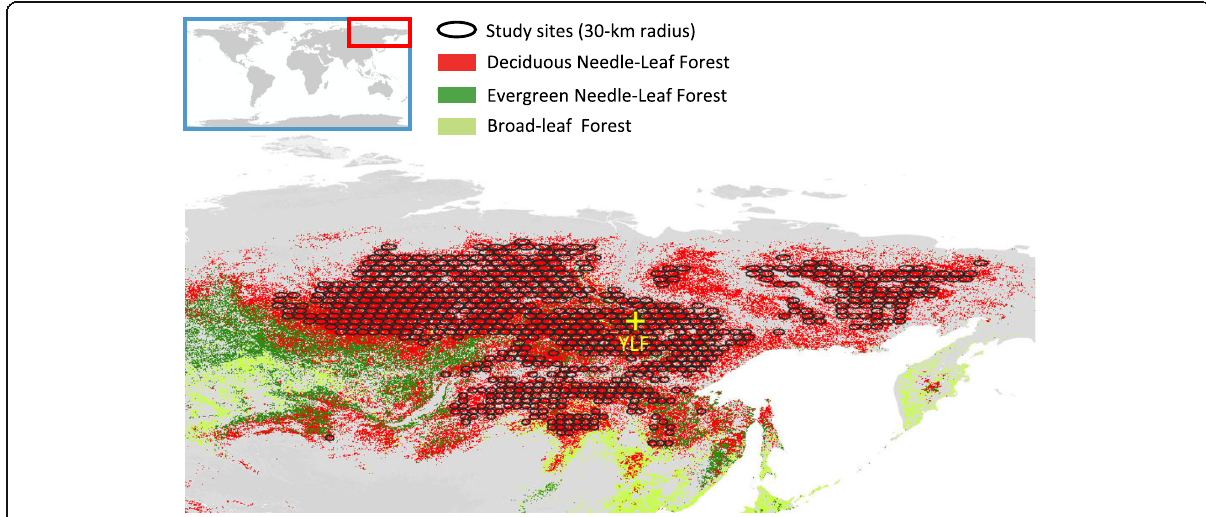
Fig. 1 Study sites (black circles). Yellow cross shows the Yakutsk larch forest, the study site of Arakida et al. (2017). The vegetation data shown by red, green, and light-green shades are from the global land cover dataset (GLC2000: European Commission, Joint Research Centre 2003). Gray areas indicate the planetary continental data provided by Esri, Global Mapping International, US Central Intelligence Agency (The World Factbook). The same continental data are used in subsequent